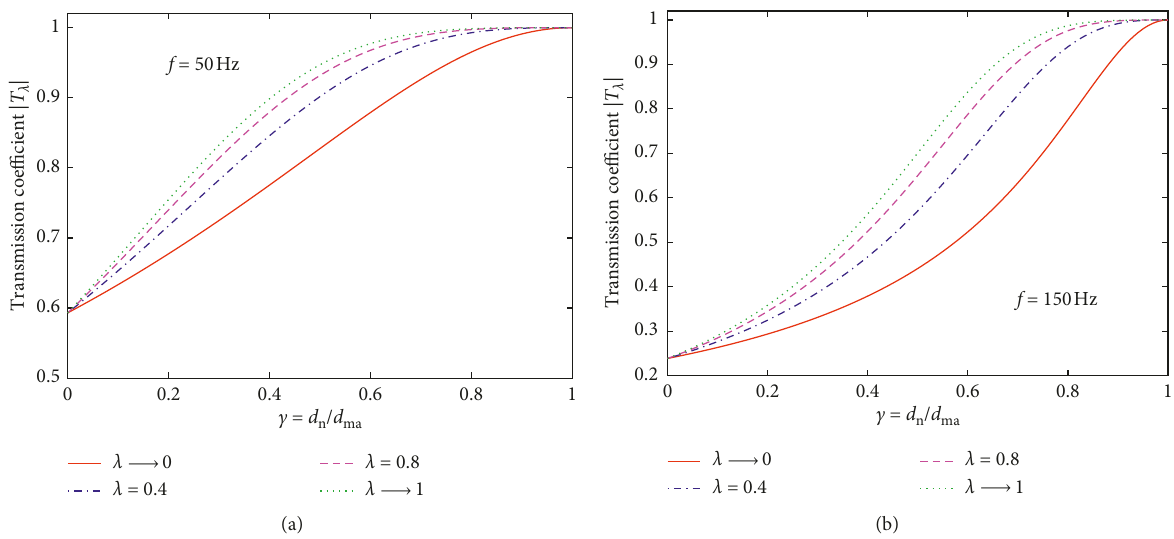
Figure 7: Transmission coefficient